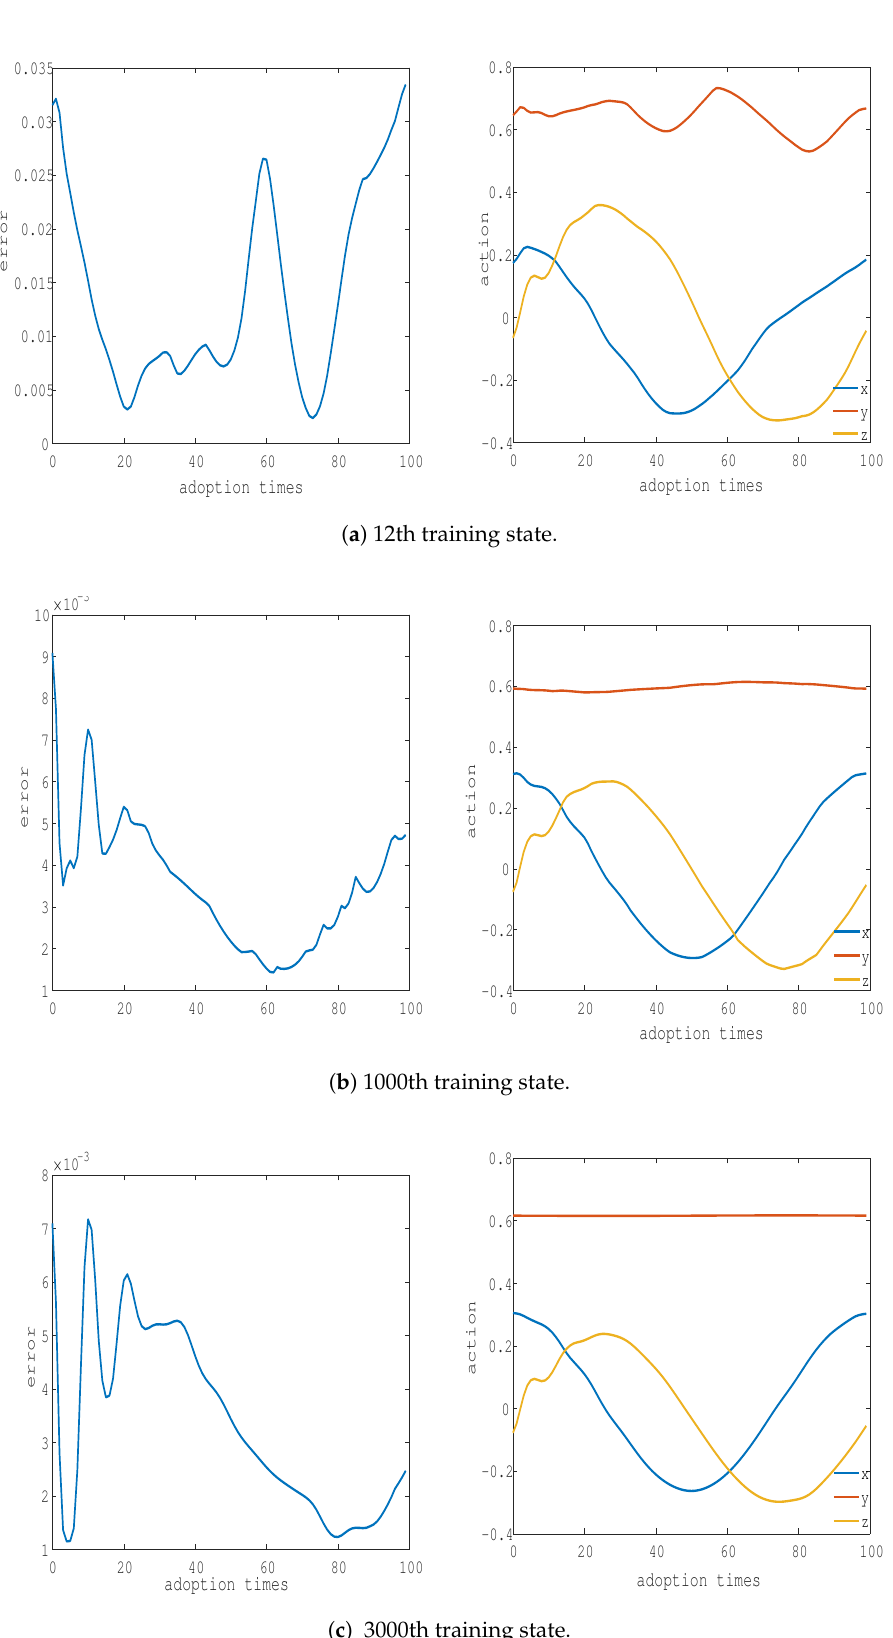
Figure 12. Sampling of the system training process: ( left ) error curve; ( right ) output